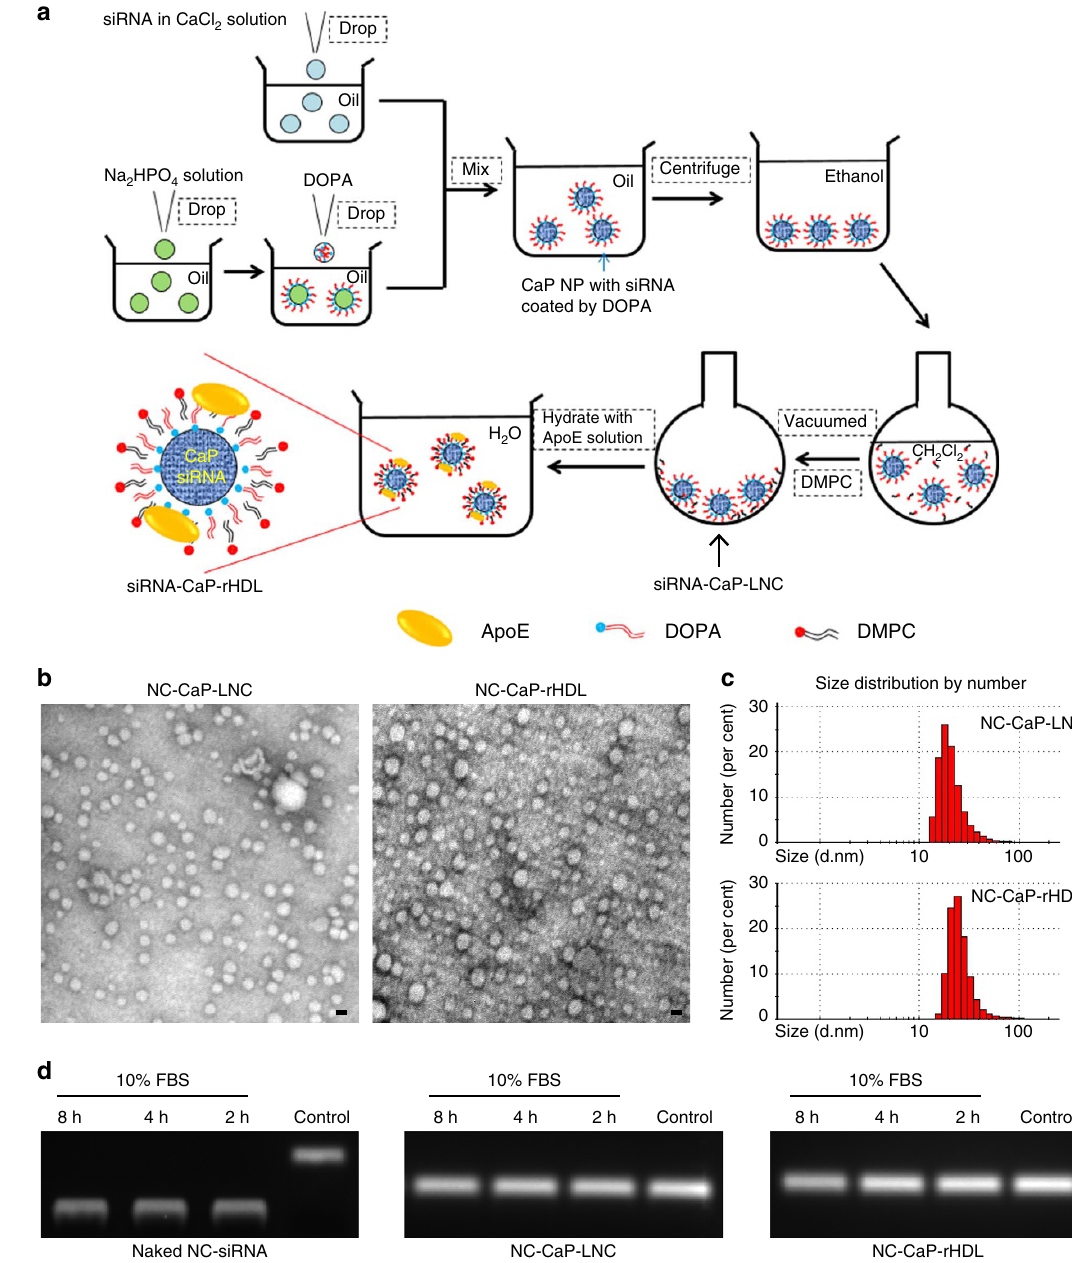
Figure 1 | Preparation and characterization of siRNA-loaded CaP-rHDL (siRNA-CaP-rHDL). ( a ) The outline for the preparation of siRNA-CaP-rHDL. ( b ) Morphology and particle size of negative control siRNA-loaded CaP-LNC (NC-CaP-LNC) and CaP-rHDL (NC-CaP-rHDL) under a transmission electron microscope after negative staining with sodium phosphotungstate solution (1.75%, w/v). Scale bar, 20nm. ( c ) Particle size distribution of NC-CaP-LNC and NC-CaP-rHDL analysed by dynamic light scattering via a Zetasizer. ( d ) Serum stability of siRNA loaded by NC-CaP-LNC and NC-CaP-rHDL. Naked NC-siRNA, NC-CaP-LNC and NC-CaP-rHDL were dissolved in PBS containing 10% serum and incubated at 37 (cid:2) C. At different incubation times, aliquots containing 1 m g siRNA was collected, destroyed by lysis buffer to release siRNA and subjected to siRNA detection via agarose gel